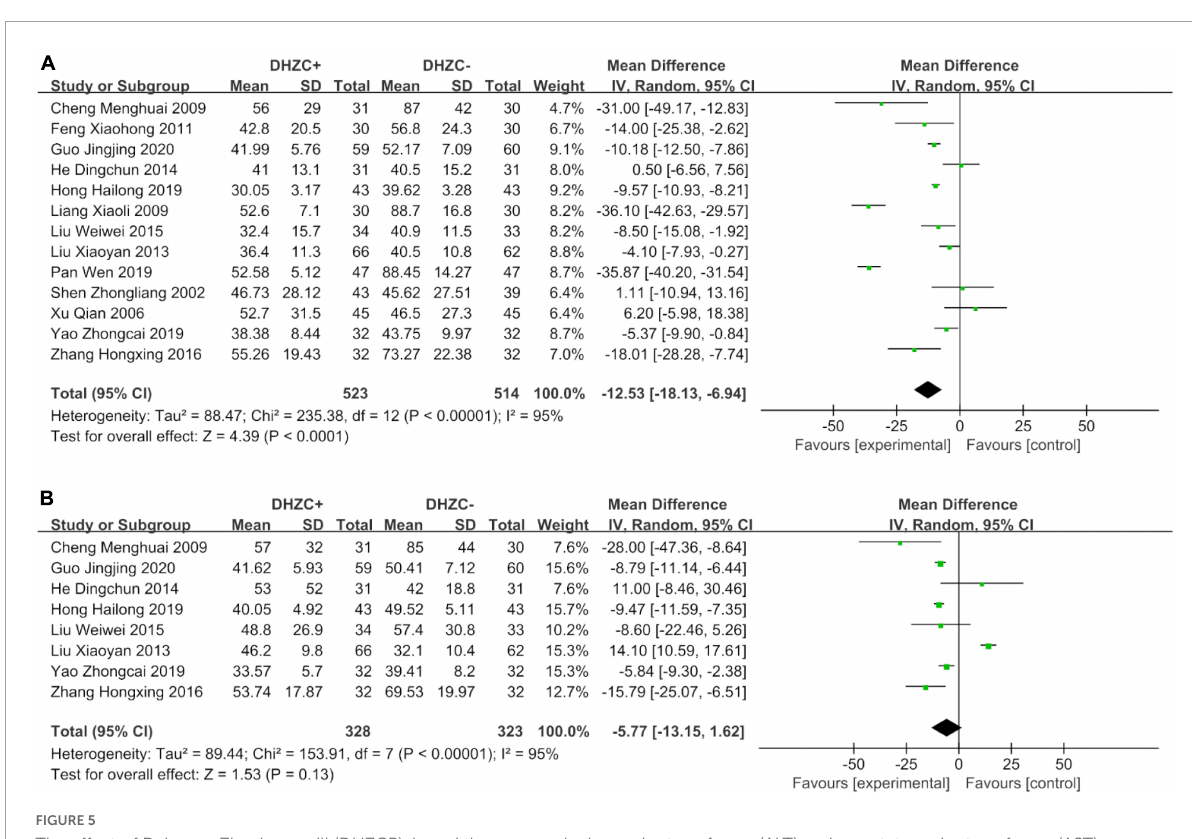
FIGURE5 The effect of Dahuang Zhechong pill (DHZCP)-based therapy on alanine aminotransferase (ALT) and aspartate aminotransferase (AST). Random-effects models were applied. (A) Total ALT; (B) Total AST.